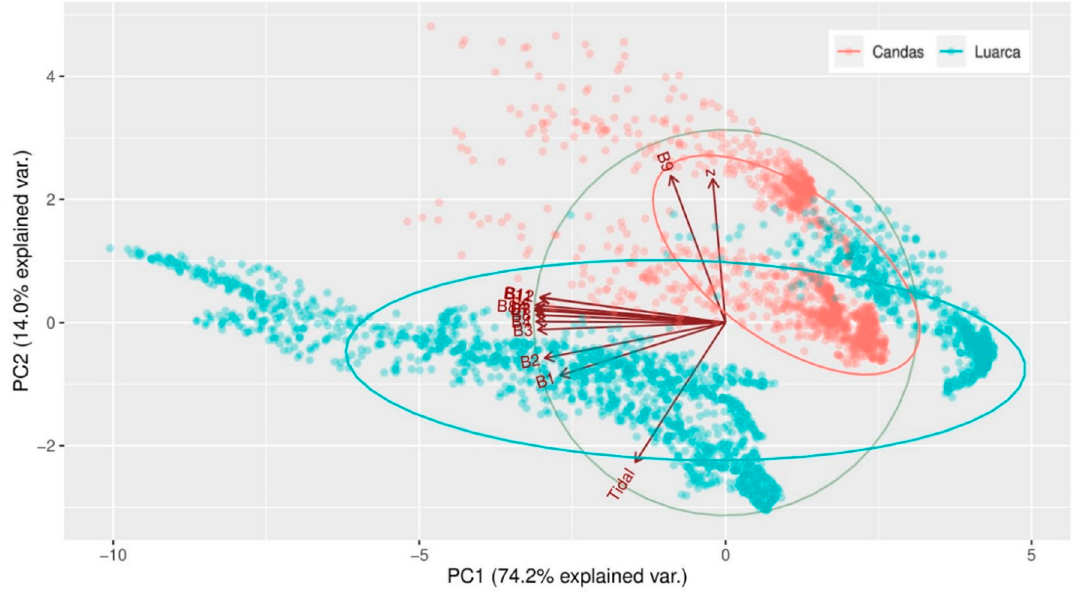
Figure 4. Principal component analysis of the